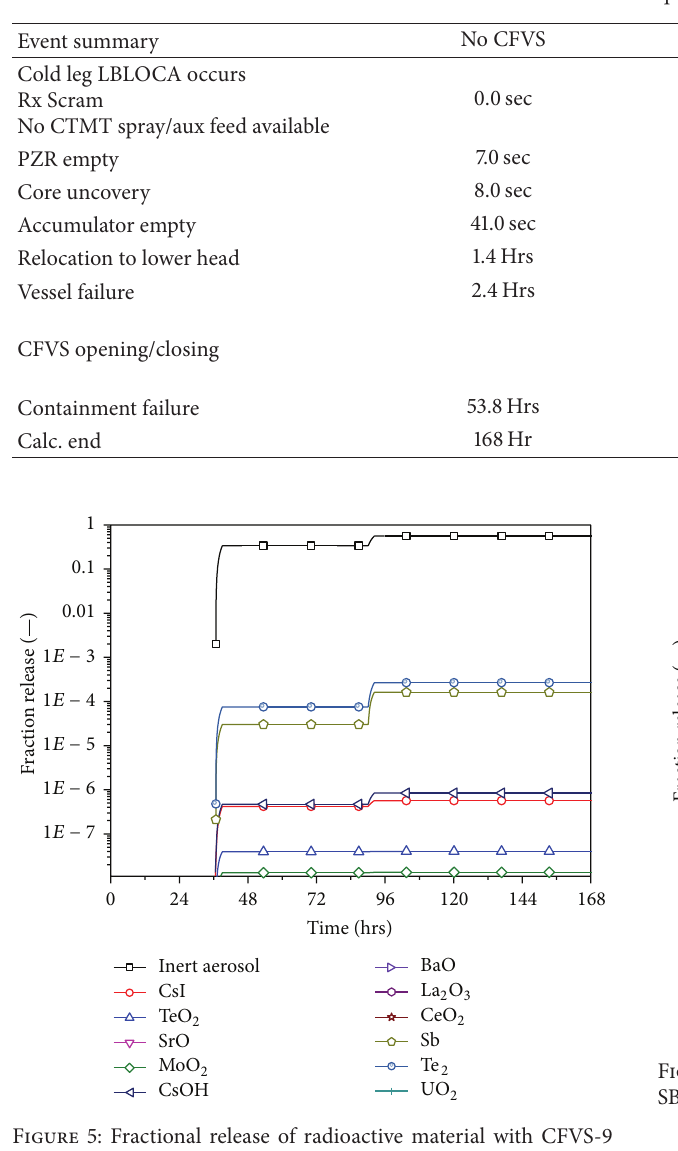
Figure 5: Fractional release of radioactive material with CFVS-9 case in extended SBO.